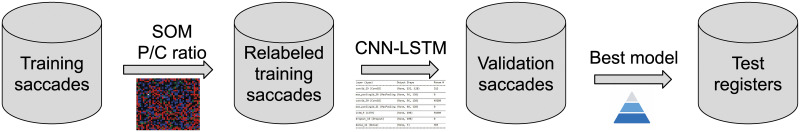
Overview of the proposed approach.Training saccades are relabeled via SOM in combination with the tuning of the P/C (presymptomatic/control) ratio, then the CNN-LSTM is trained on this data, the best model on the validation set is applied on the test saccades, and finally the test registers get classified.